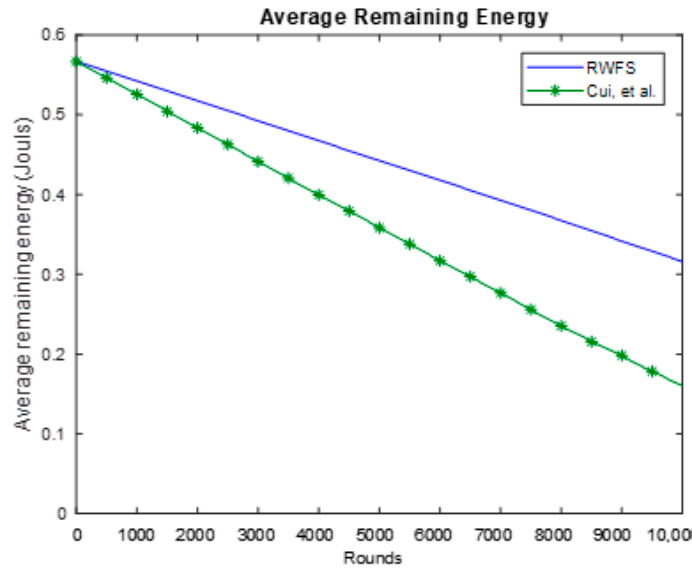
Figure 8. The average remaining energy analysis between RWFS (the proposed scheme) and the Cui et al. scheme. The average energy of all nodes in the network is calculated at each round for a duration of 10,000 rounds.